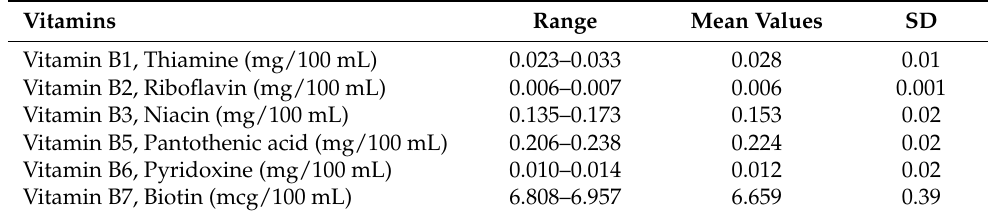
Table 3. Vitamin concentration in Halari donkey